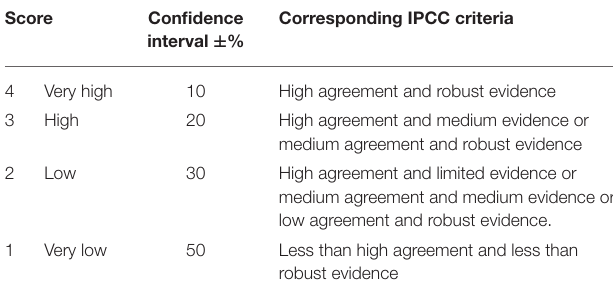
TABLE 3 | “Score” for evaluating the quality the catch reconstruction, with their confidence intervals (adapted from Mastrandrea et al., 2010).